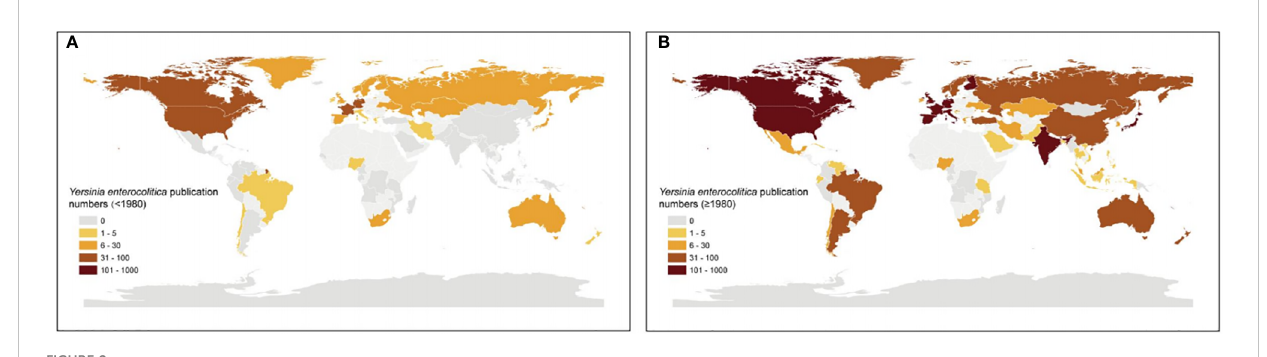
FIGURE 2 Worldwide Y. enterocolitica publication numbers by Bibliometric analysis. Worldwide Y. enterocolitica publication numbers for countries reporting data (A) before 1980 and (B) after 1980. Publication numbers were ranked into quintiles representing low (bright yellow) to intermediate (yellow) and high